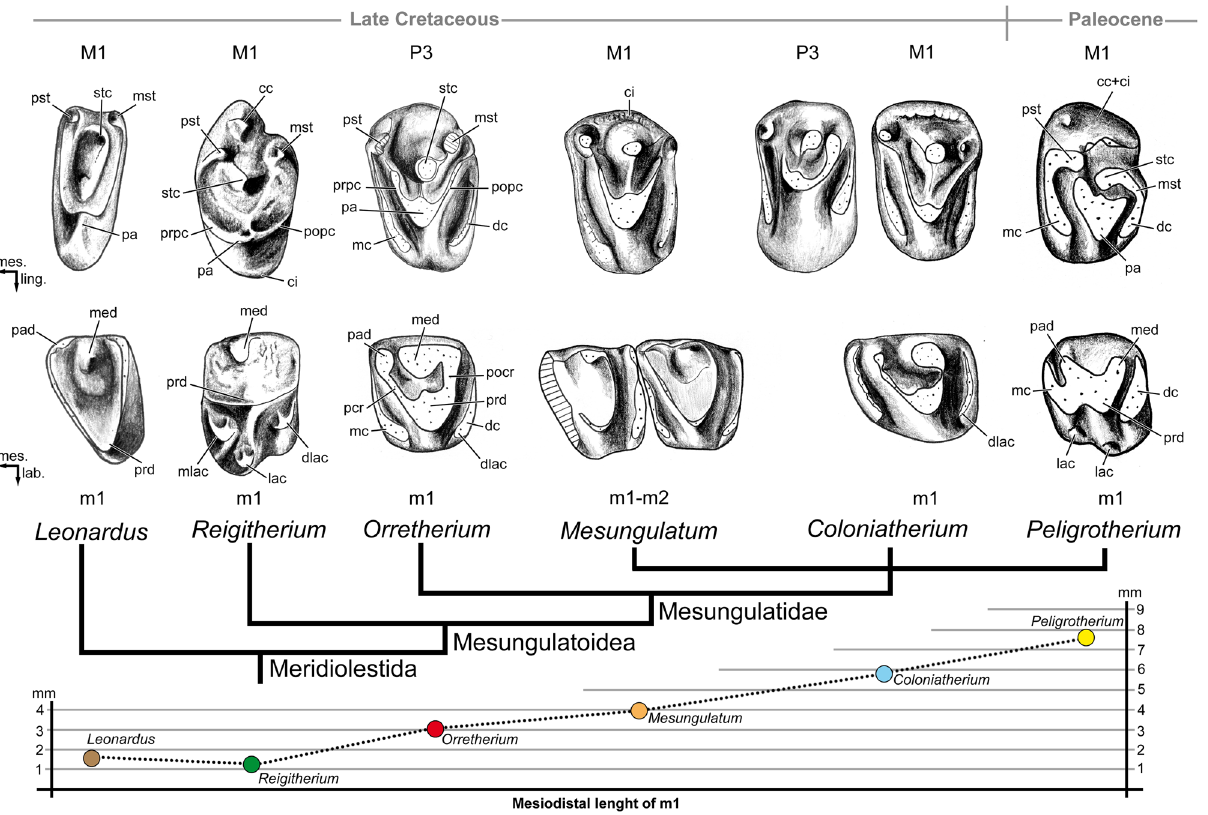
Figure 8. Comparison of selected left upper/lower postcanine teeth of some meridiolestian mammals and their size based on m1. Leonardus is based on MACN-RN 172 (M1) and MACN-RN 1097 (m1), as interpreted by Rougier et al. 15 ; Reigitherium , Harper et al. 16 : Fig. 3a and MPEF-PV 2238, M1; MPEF-PV 2317, m1); Orretherium , CPAP-5008 (P3) and CPAP-5007 (m1); Mesungulatum , MACN-RN 03 (M1) and MACN-RN 06 (m1-m2); Coloniatherium , MPEF-PV 2081 (P3), MPEF-PV 2078 (M1) and MPEF-PV 2064 (m1), as interpreted by Rougier et al. 12,15 ; and Peligrotherium , MPEF-PV 2351, as interpreted by Páez Arango 24 and Rougier et al. 15 . See also Fig. S3. For comparative purposes the M1/m1 of Leonardus , m1 of Reigitherium , P3 of Reigitherium , and P3 of Coloniatherium are inverted. Drawings made by A.G.M. cc cingular cusp, ci cingulum, dc